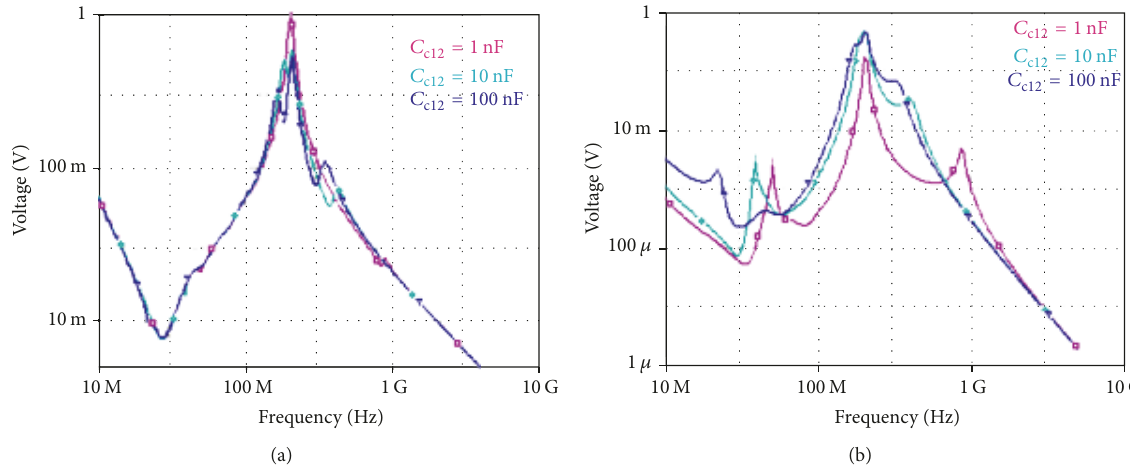
= 100 nF, 𝐶 = 10nF, and 𝐶 = 1nF, 10nF, and 100nF. (a) First core. (b) Second b 12 p 12 C 12